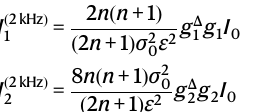
triangles)arethecorrespondingQLpoints. b - f Speci fi cexperimentalresultsofHG 1 to HG 5 modes. The gray dashed lines are the QCR bounds of parameters g 1 and g 2 , where the cross points (red triangles) are the theoretical QL points. The dark dashed lines are the experimental precision limits of parameters g 1 and g 2 , where the cross points (purple cross marks) are the theoretical predictions of experi- mental results given by Eq. (36) and Eq.